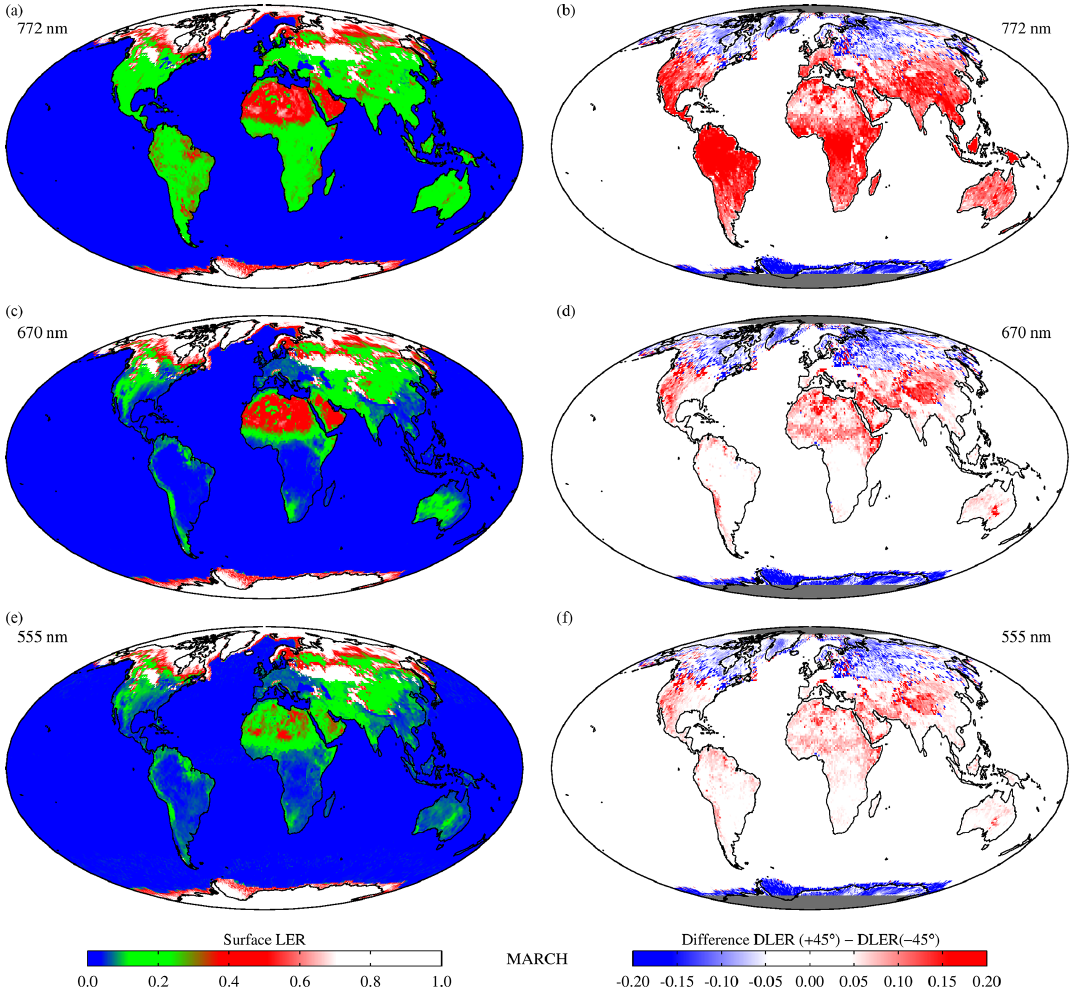
Figure 6. (a, c, e) Global maps of the GOME-2 surface LER for calendar month March and for 772, 670, and 555nm. (b, d, f) Global maps of the surface anisotropy parameter, defined as the difference between GOME-2 surface DLER at viewing angles of + 45 ◦ and − 45 ◦ . The surface anisotropy can be large, especially for vegetated surfaces at wavelengths beyond 700nm. Over the oceans only non-directional surface LER is provided, as explained in Sect. 2.2.